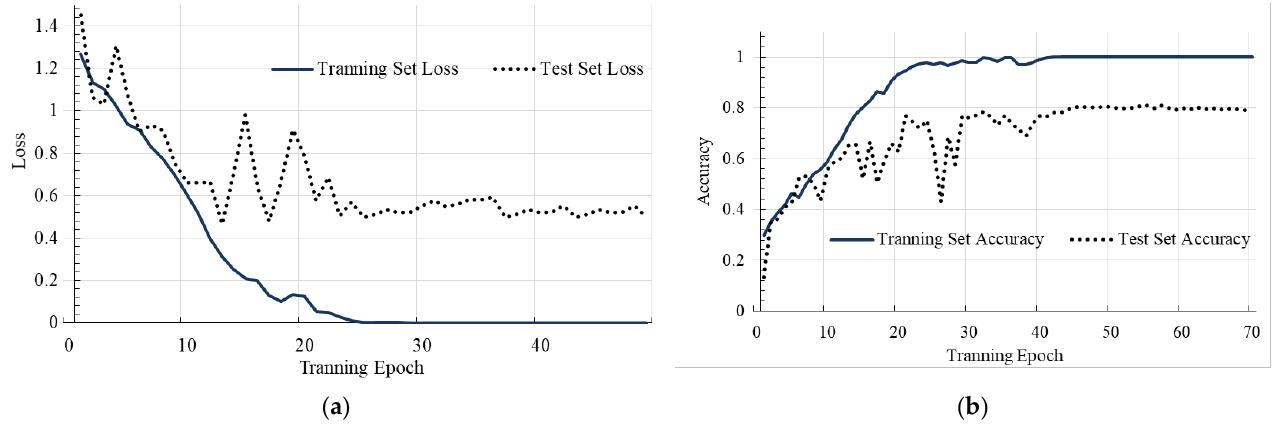
Figure 7. Loss plot and accuracy plot of training and test sets of RAVDESS dataset for Single DL framework. ( a ) Loss vs. Training Epoch; ( b ) Accuracy vs. Training Epoch.